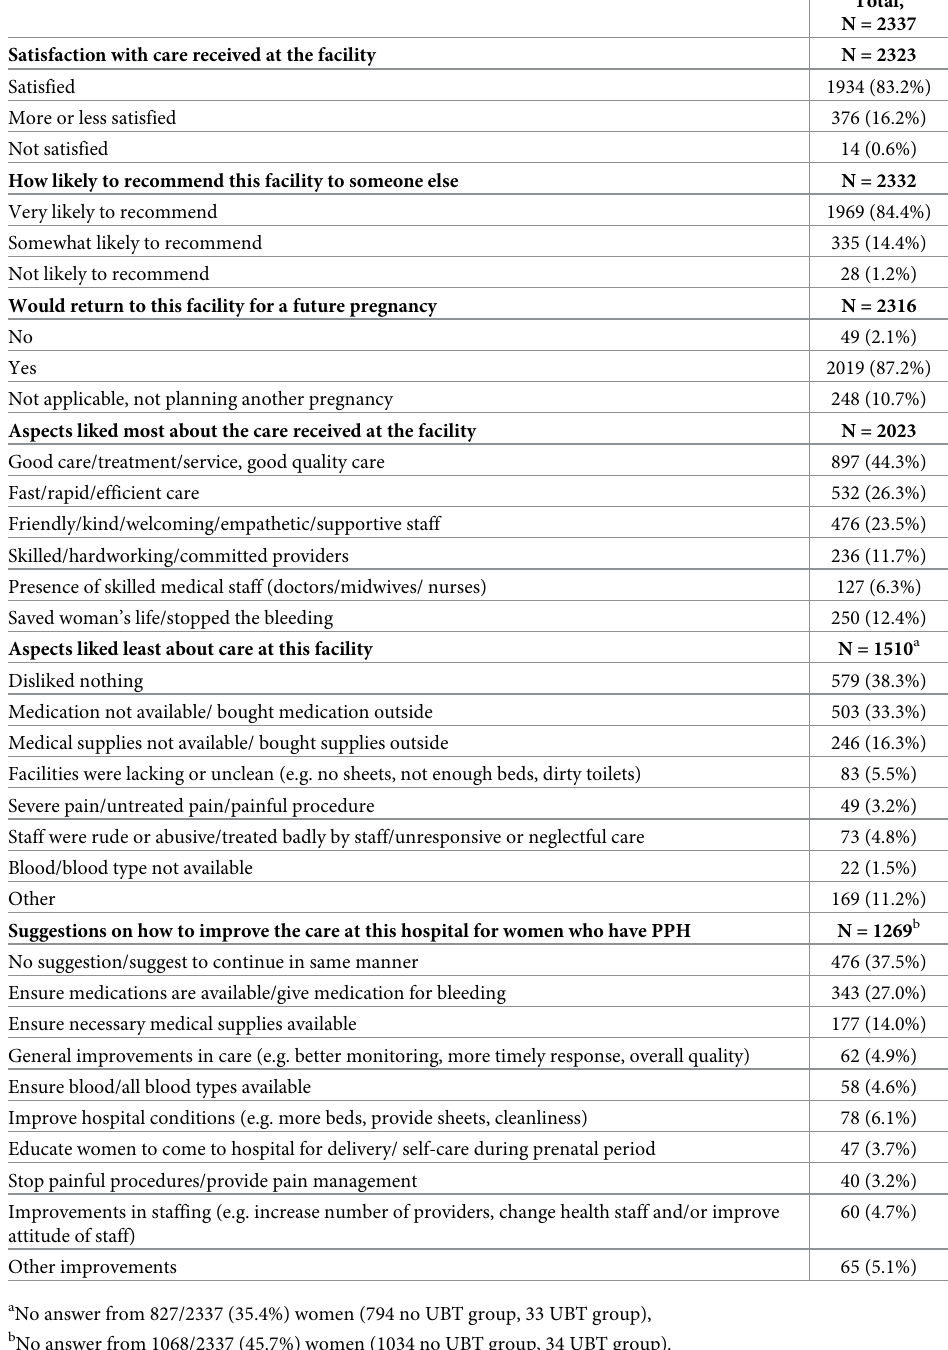
Table 2. Self-reported experiences with care among 2339 women diagnosed with PPH before discharge after